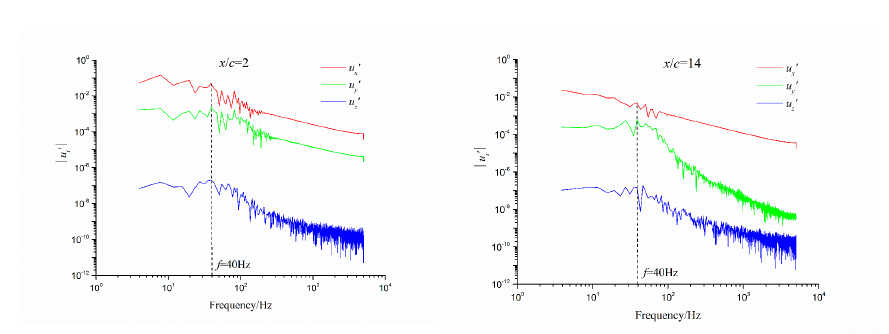
( b ) Spectral plots of velocity fluctuation at f = 30 Hz, left: |(cid:1873) (cid:3051)(cid:4593) |, right: |(cid:1873) (cid:3052)(cid:4593) | .